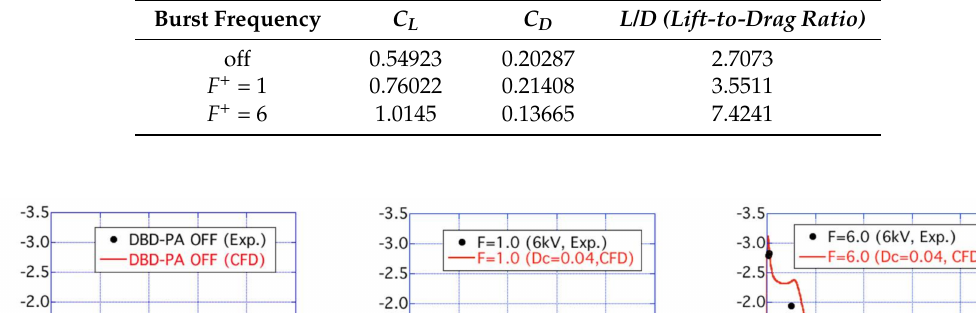
Table 1. Aerodynamic Coefficients (CFD): α = 14 ◦ , BR = 10%, D c = 1.0, Re = 6.3 × 10 4 .